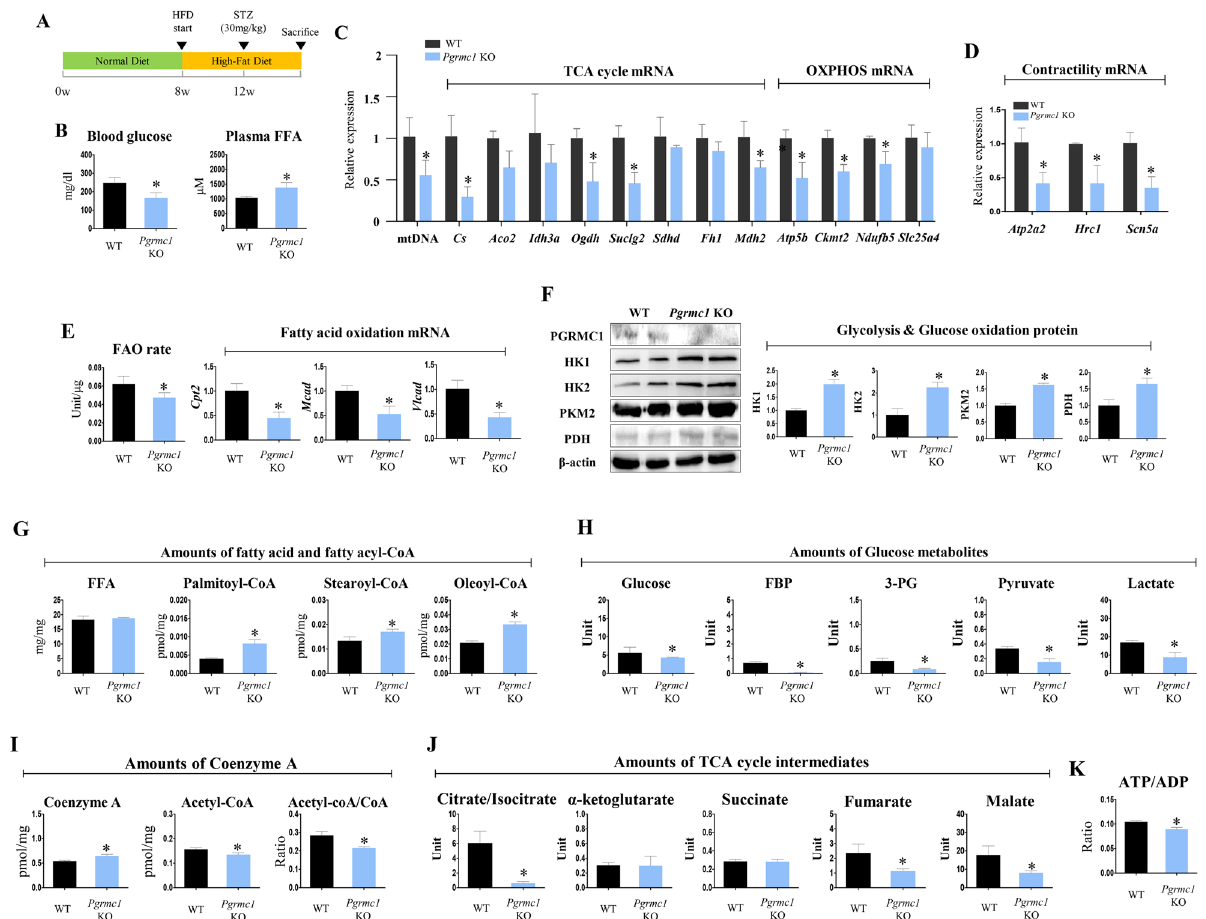
Figure 3. Pgrmc1 KO mice increases cardiac fatty acyl-CoA levels, but suppresses production of acetyl-CoA and ATP. ( A ) Schematic diagram which presents experimental schedule for HFD state. (B) Levels of blood glucose (mg/dl) and plasma FFA (µM) in HFD WT and Pgrmc1 KO mice. ( C ) Expression of mitochondrial DNA (mtDNA) in hearts of HFD WT and Pgrmc1 KO mice. Nuclear DNA was used for an internal control. mRNA expression of TCA cycle and OXPHOS in hearts of HFD WT and Pgrmc1 KO mice. Rplp0 was used for an internal control. ( D ) mRNA expression of contractility markers in hearts of HFD WT and Pgrmc1 KO mice. Rplp0 was used for an internal control. ( E ) Fatty acid oxidation activity in hearts of HFD WT and Pgrmc1 KO mice. mRNA expression of fatty acid oxidation genes in hearts of HFD WT and Pgrmc1 KO mice. Rplp0 was used for an internal control. ( F ) Western blot analysis and quantification of glycolysis and glucose oxidation genes in hearts of HFD WT and Pgrmc1 KO mice. β-actin was used for an internal control. ( G ) Cardiac FFA level (µM) and fatty acyl-CoA levels (pmol/mg) in HFD WT and Pgrmc1 KO mice. ( H ) Levels of glucose metabolites (unit) in HFD WT and Pgrmc1 KO mice. ( I ) Levels of coenzyme A (CoA) and acetyl-CoA in HFD WT and Pgrmc1 KO mice. ( J ) Levels of TCA cycle intermediates in HFD WT and Pgrmc1 KO mice. ( K ) Ratio of ATP per ADP in HFD WT and Pgrmc1 KO mice. Values represent means ± SD. *p < 0.05. Student’s t test was performed. Total numbers of mice used for experiment were 10 (HFD WT) and 7 (HFD Pgrmc1